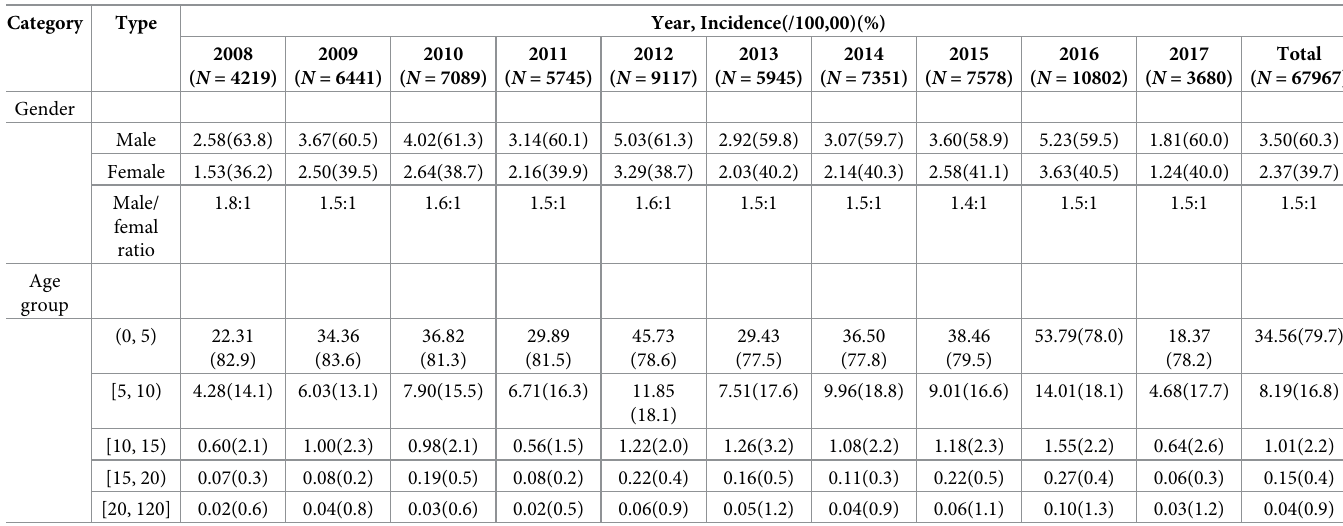
Table 1. Demographic distributions of